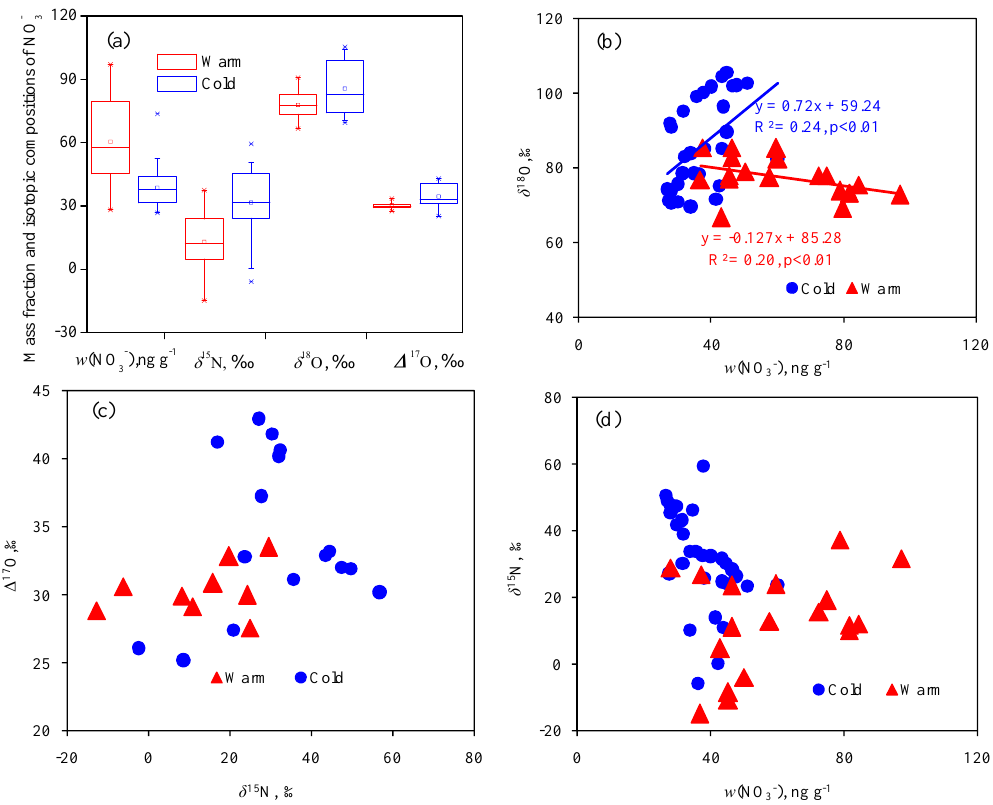
) , δ 15 N, δ 18 O and (cid:49) 17 O of NO − Figure 8. w (NO − in warm and cold season samples from snowpit P1. Summary statistics by season are 3 3 shown in (a) , with box and whisker plots representing maximum (top X symbol), minimum (bottom X symbol), percentiles (5th, 25th, 75th, and 95th), and median (50th, solid line) and mean (open square near center of each box). The seasonal relationships between w (NO − δ 18 O, δ 15 N and (cid:49) 17 O, and w (NO − ) and δ 15 N of NO − are shown in (b) , (c) and (d) 3 3